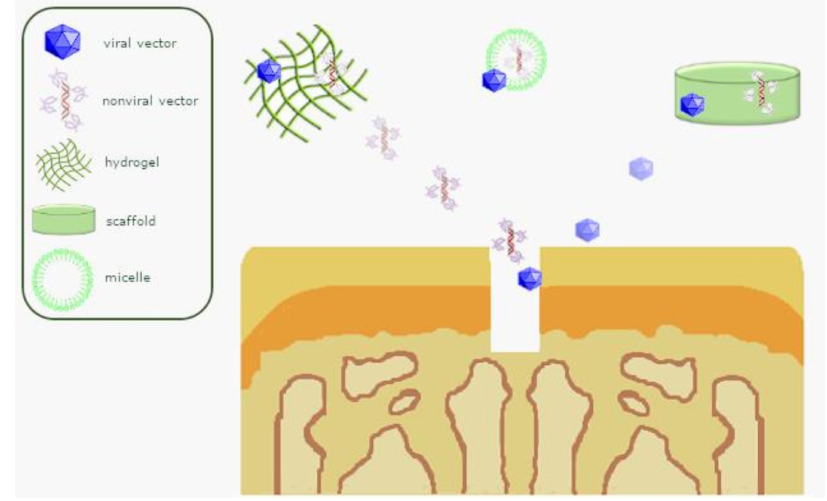
Figure 3. Overview of sca ff old-guided gene transfer mechanisms for osteochondral